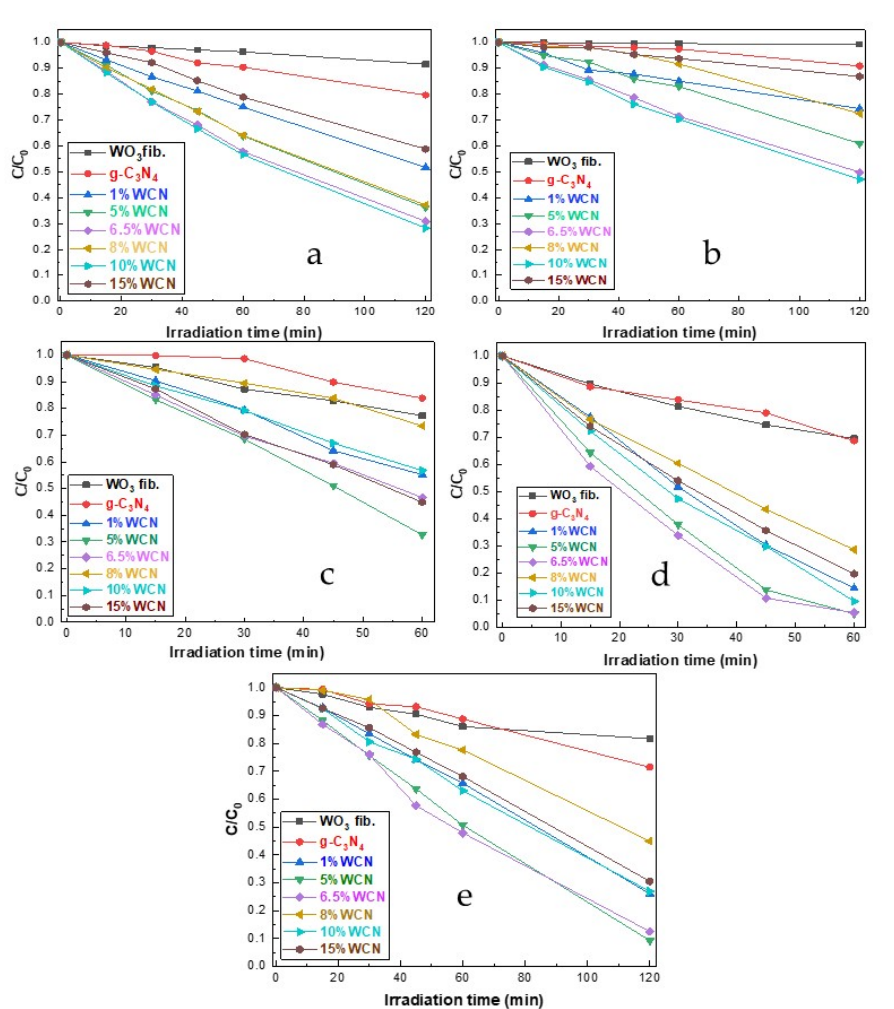
Figure 6. Photocatalytic degradation kinetics of phenol ( a ) and phenolics ( b ) in single system; and phenol ( c ), phenolics ( d ) and Cr (VI) ( e ) in binary system with the presence of synthesized catalysts under simulated solar light irradiation. Table 2. Photocatalytic degradation kinetics (k, min −1 ; t 1/2 , min; R 2 ) of phenol and phenolic compounds in single system.